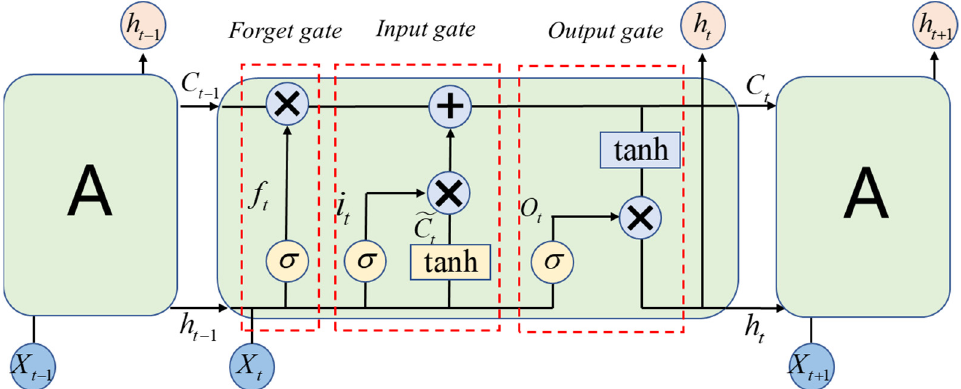
Figure 1. LSTM structure.